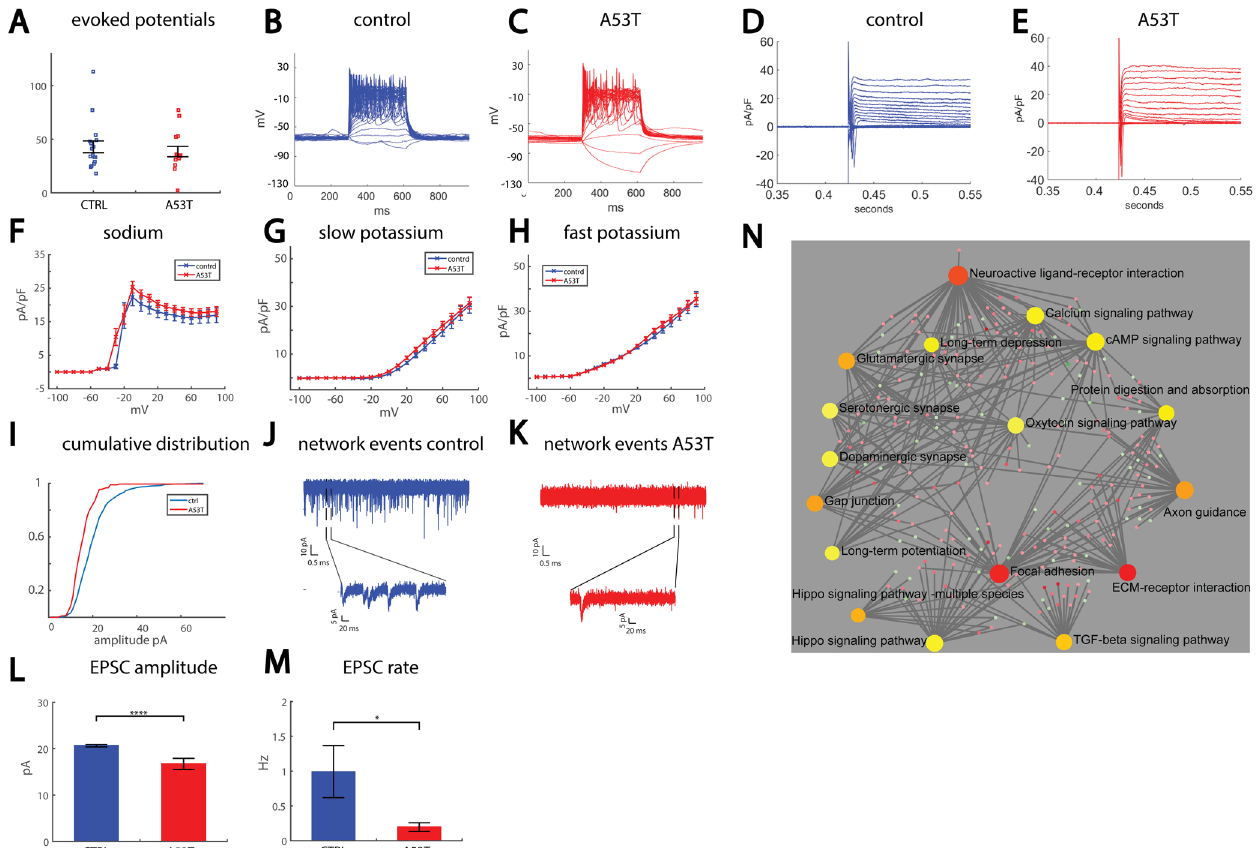
Fig. 5 Reduced synaptic activity in neurons derived from an engineered line of iPSCs with an A53T mutation in the SNCA gene compared to isogenic controls. A No signi fi cant change in the excitability of the A53T neurons compared to control neurons. B Example recording of action potentials in current-clamp mode of a control neuron. C Example recording of action potentials in current-clamp mode of an A53T neuron. Sodium currents of A53T neurons open at a lower depolarization potential than control neurons. D Example recording of sodium and potassium currents in voltage-clamp mode in a control neuron. E Example recording of sodium and potassium currents in voltage-clamp mode in an A53T neuron. F No signi fi cant changes were observed in the sodium currents of the A53T neurons compared to controls. G No signi fi cant changes were observed in the slow potassium currents in the A53T neurons. H No signi fi cant changes were observed in the fast potassium currents in the A53T neurons. I The cumulative distribution of the amplitudes of EPSCs is left-shifted in A53T neurons compared